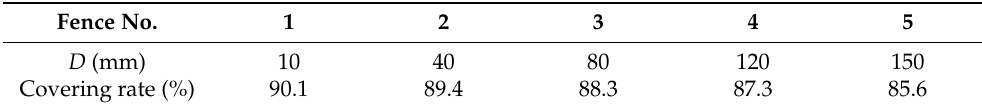
Table 2. Wind and wave test design.